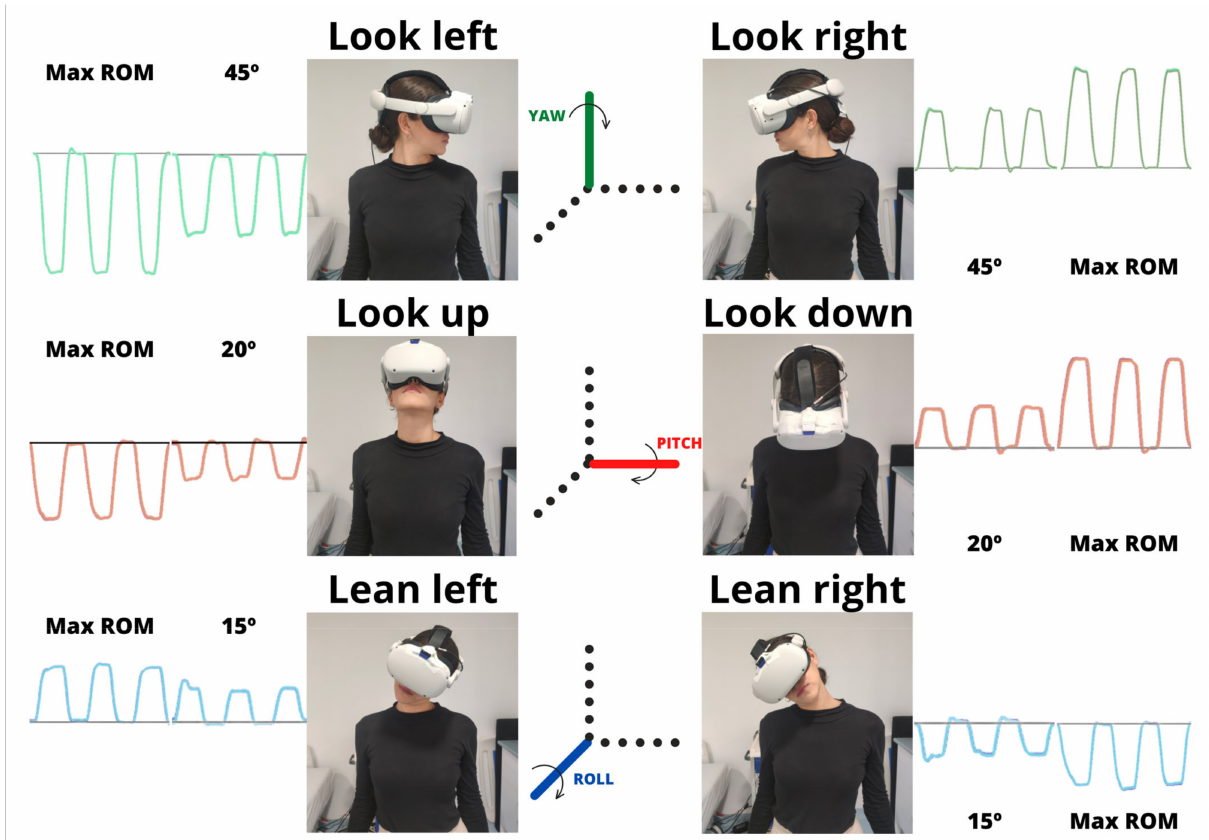
Figure 3. Subject performing the six maximum movements and the corresponding axis. Max ROM—maximum range of motion. The black lines represent 0 ◦ of the selected